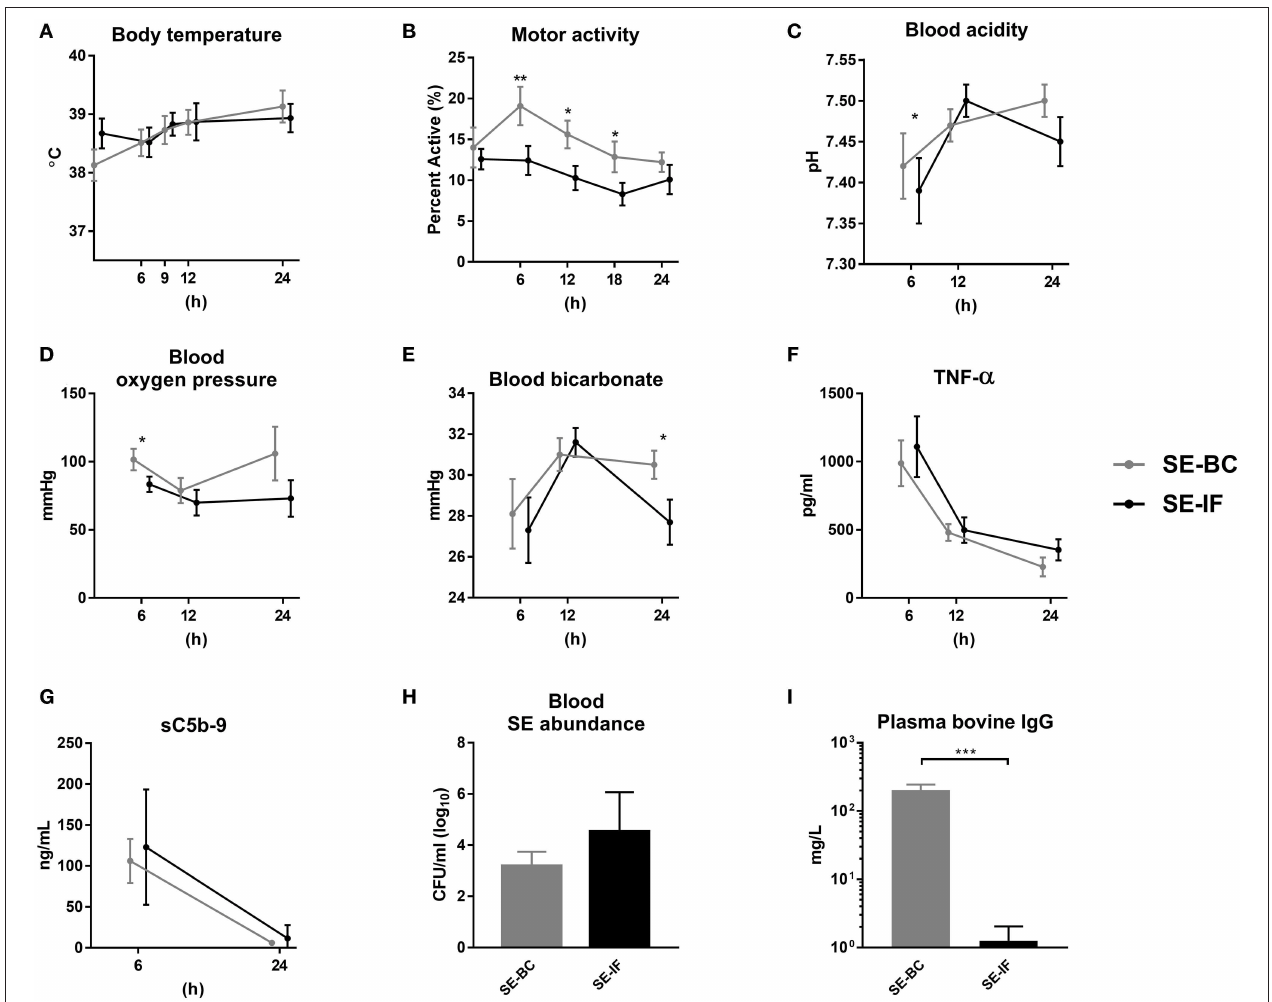
FIGURE 4 | Two days of bovine colostrum feeding has no impact on response to Staphylococcus epidermidis bacteremia, even when maternal antibodies are withheld. Results of Experiment 4 where preterm pigs were infused with Staphylococcus epidermidis (SE) on day 3, without any previous immunization (plasma infusion) and fed bovine colostrum (SE-BC) or infant formula (SE-IF). (A) Body temperature 0–24h post inoculation. (B) Motor activity, shown as the fraction of time with physical activity at 0–24h post inoculation. (C) Blood pH 6–24h post inoculation. (D) Blood oxygen pressure 6–24h post inoculation. (C) Blood bicarbonate levels 6–24h post inoculation. (F) Plasma levels of tumor necrosis factor alpha (TNF- α ) 6–24h post inoculation. (G) Plasma levels of soluble terminal complement complexes (sC5b-9) 6–12h post inoculation. (H) Abundance of SE in blood at euthanasia, shown as colony-forming units per milliliter of whole blood. (I) Plasma levels of bovine immunoglobulin G (IgG) at euthanasia. (A–F) Presented as means with corresponding standard errors. *: Effect of diet ( p < 0.05), **: Effect of diet ( p < 0.01), ***: Effect of diet ( p < 0.001).